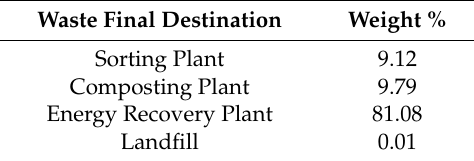
Table 1. Waste streams separation considered for this study by final destination, for